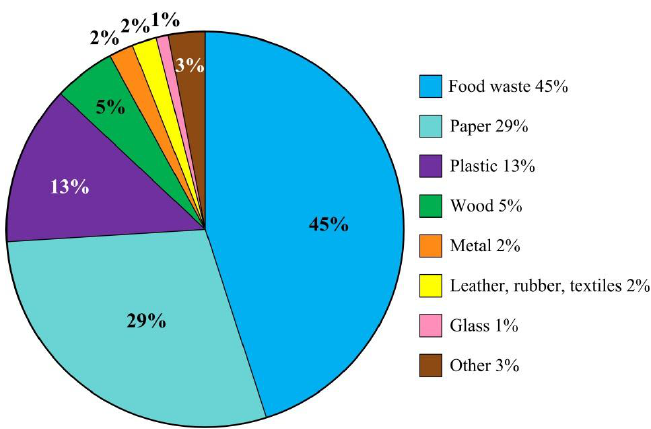
Figure 7. MSW structure of the Kemerovo region (No. 1).